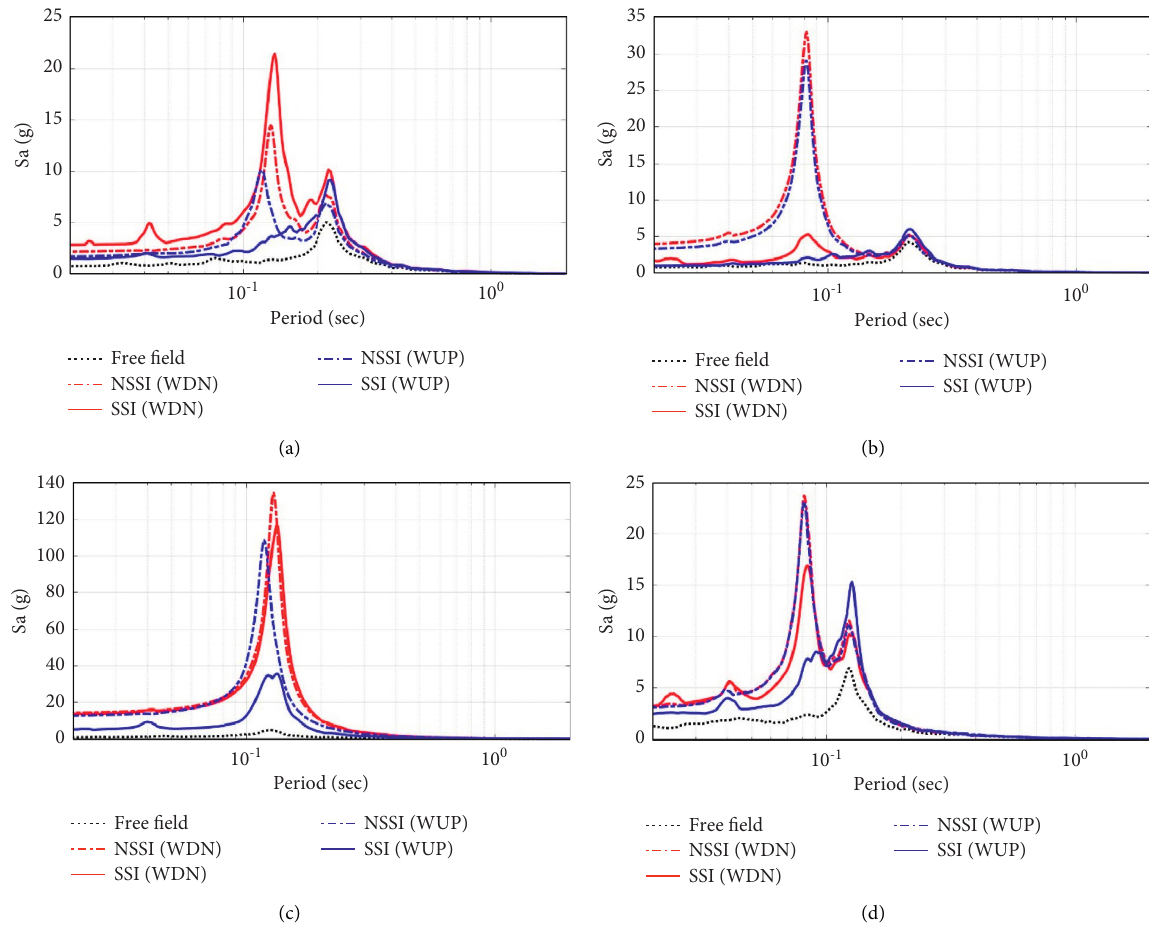
Figure 12: ARS at the top of the 1 st floor according to the width change for WS and WR in each direction. (a) WS-EW, (b) WS-NS, (c) WR- EW, (d)